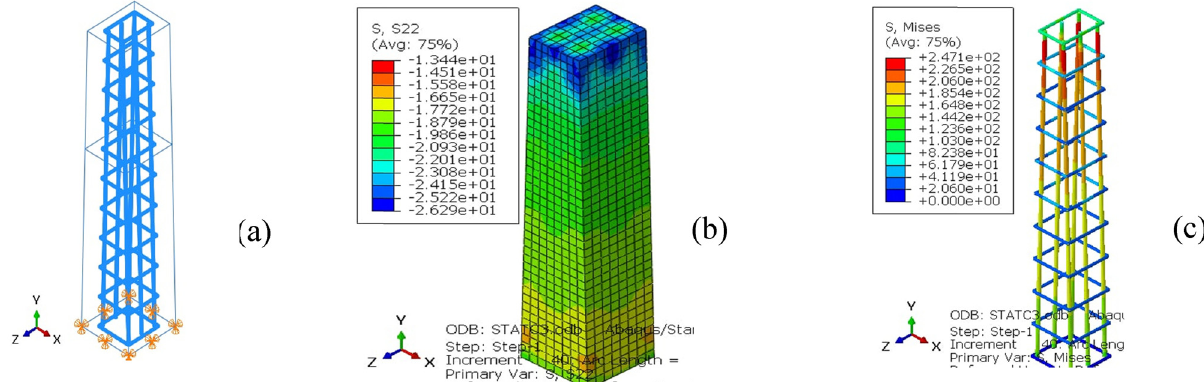
Figure 11: ( a ) FE Model No. 3, ( b ) stress in the y - direction, and ( c ) stress in steel